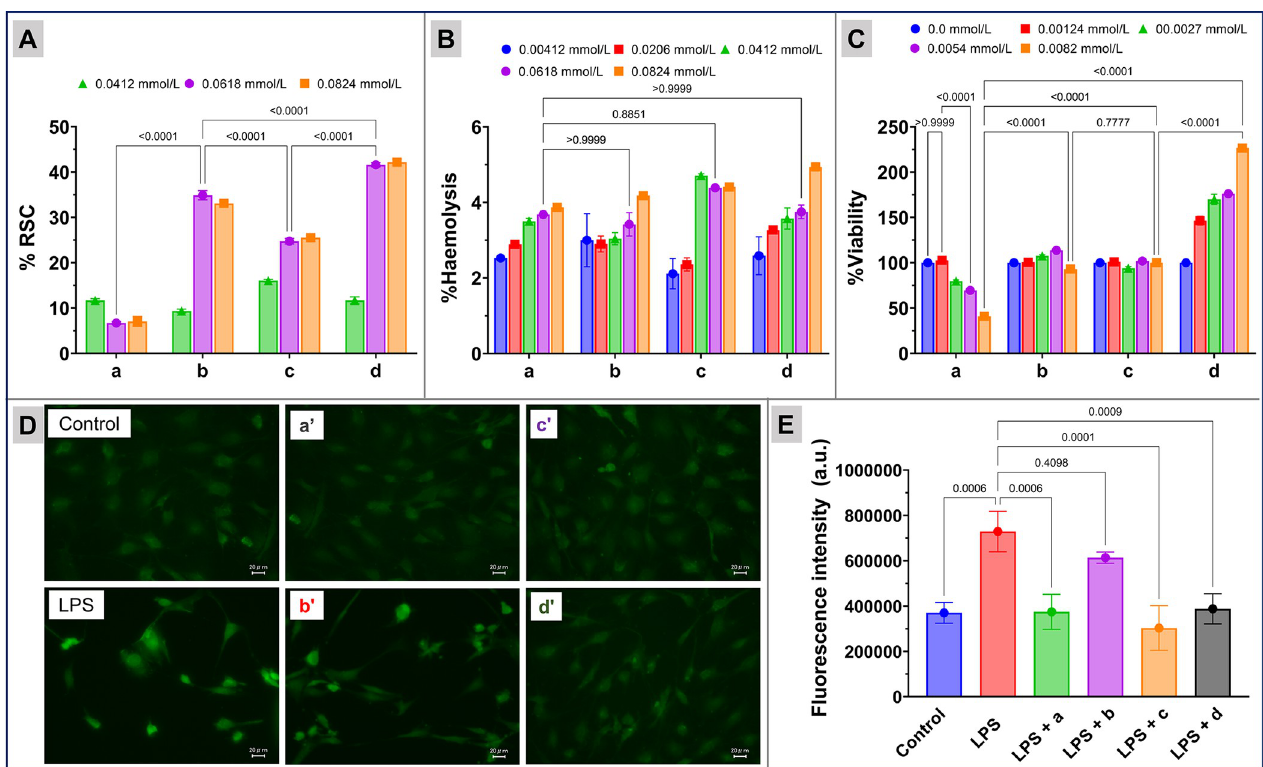
Fig 3. Radical scavenging capacity (RSC) and toxicity of nanoparticles: Panel A: %RSC. Panel B: Haemocompatibility (% Haemolysis). Panel C: %cell viability of mouse RAW 264.7 macrophages treated with Cur-Ag (a), Cur-Ag INH (b), Cur-Ag Tyr (c), and Cur-Ag Qrc (d) nanoparticles. Panel D: generation of ROS by 2’,7’-dichlorodihydrofluorescein diacetate assay in mouse macrophage cells co-treated with lipopolysaccharides (LPS) and nanoparticles. Panel E: relative fluorescent intensity. In Panels D and E, the a’, b’, c’, and d’ represent co-treatment of LPS with Cur-Ag, Cur-Ag INH , Cur-Ag Tyr , or Cur-Ag Qrc nanoparticles, respectively. In Panels A, B, and C, the results are expressed as mean ± SE, whereas in Panel E, the results are expressed as mean ± SD. The data shown is a compilation of three independent trials. P-values are shown above the square brackets; p < 0.05 was considered statistically significant.